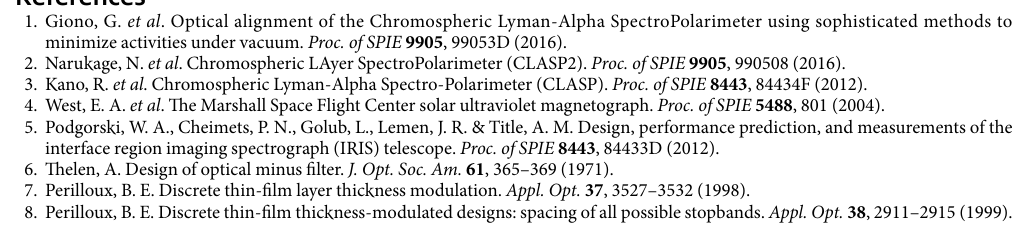
5 SCientifiC REPORts | 7: 15402 | DOI:10.1038/s41598-017-15824-5